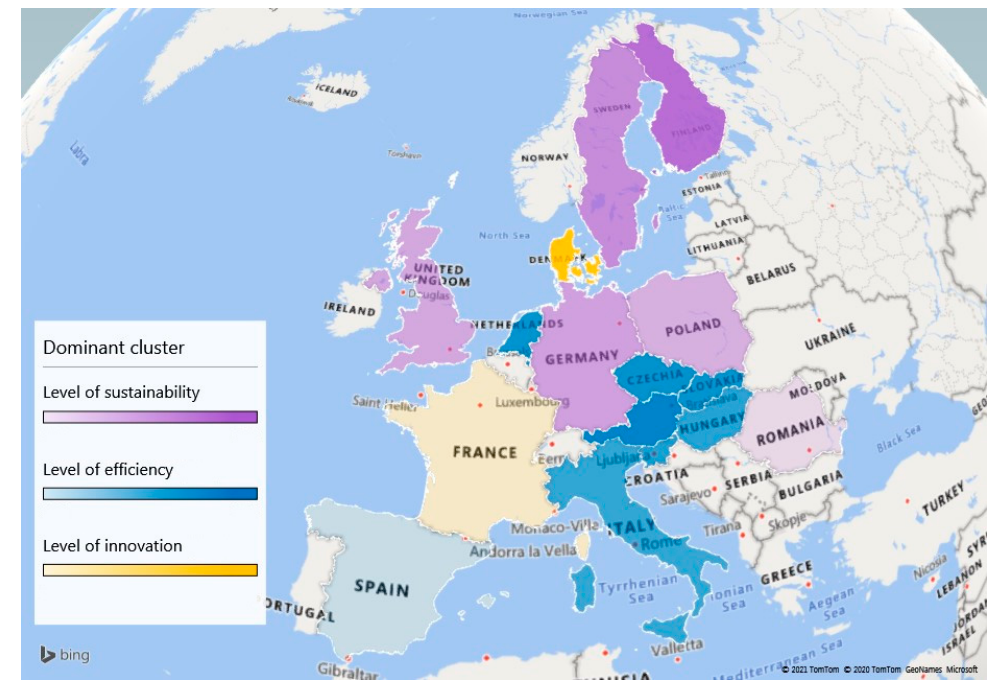
Figure 6. Dominant component of bioenergy performance.